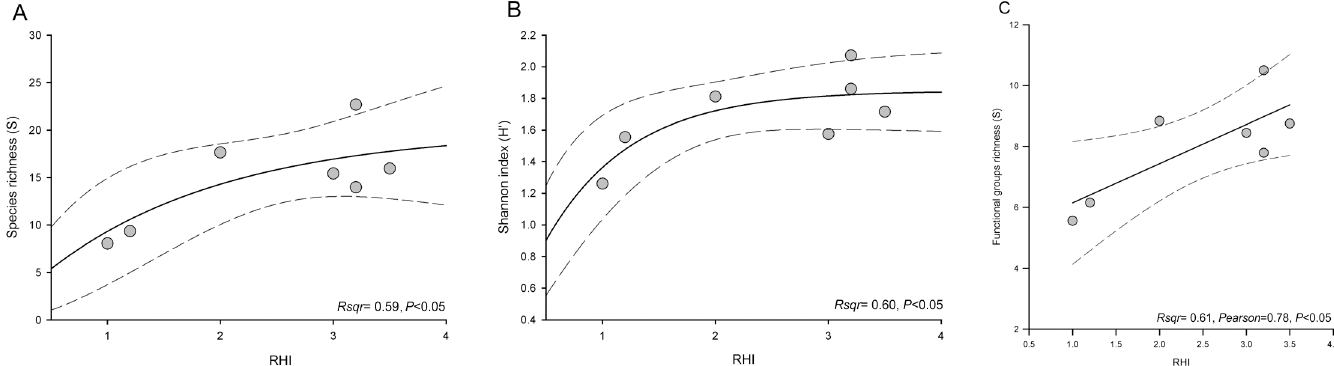
Fig 6. Relationship between RHI and the biological, ecological and functional indices of fish diversity. a) species richness, b) Shannon diversity, c) richness of functional groups of fish according to the grades of RHI at the scales of zones. Fig 6A and 6B present nonlinear regressions using an exponential raised to maximum with 2 parameters function (equation Fig 6A: f = 19.97(1-exp(-0.62x)), Fig 6B: f = 19.97(1-exp(-0.62x))) to get the best fit of the data. c) Linear regression and Pearson correlation. Dotted lines indicate the 95% confidence